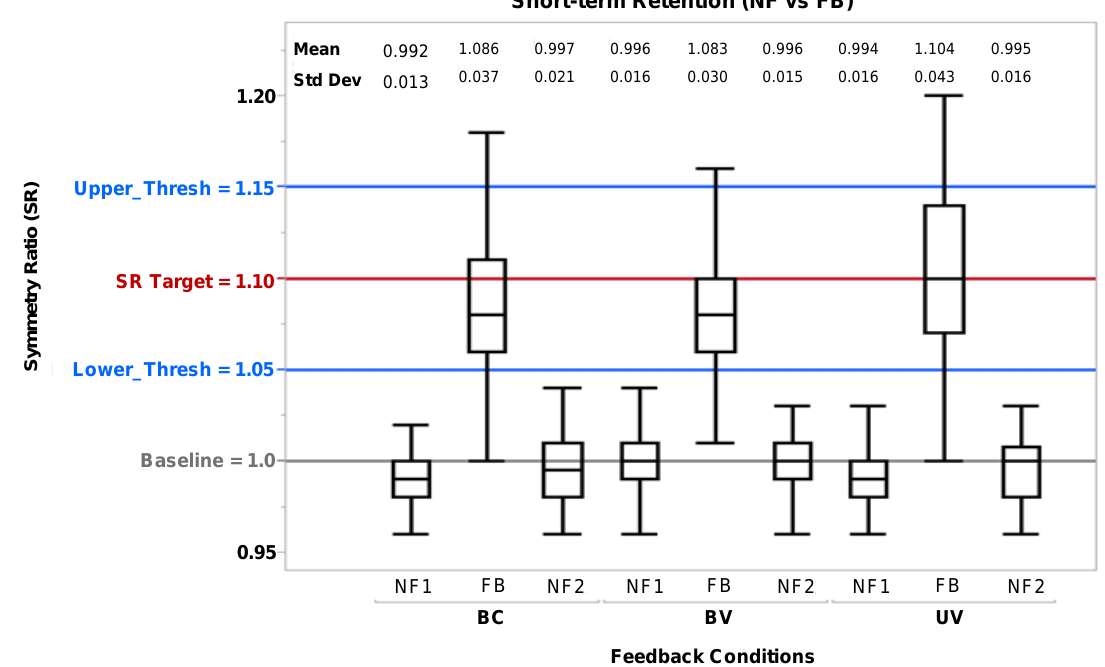
Figure 7: Short-term Retention. Box plot of SR values during No Feedback (NF) before (i.e., NF1) and after (i.e., NF2) providing vibrotactile feedback (BC, BV, UV). BC: Bidirectional control – constant vibration; BV: Bidirectional control – variable vibration; UV: Unidirectional control – variable vibration. Statistically significant differences were found only between NF and feedback conditions. Mean and standard deviations (Std Dev) are also included above. Upper and Lower Thresholds labeled as Upper_Thresh and Lower_Thresh,